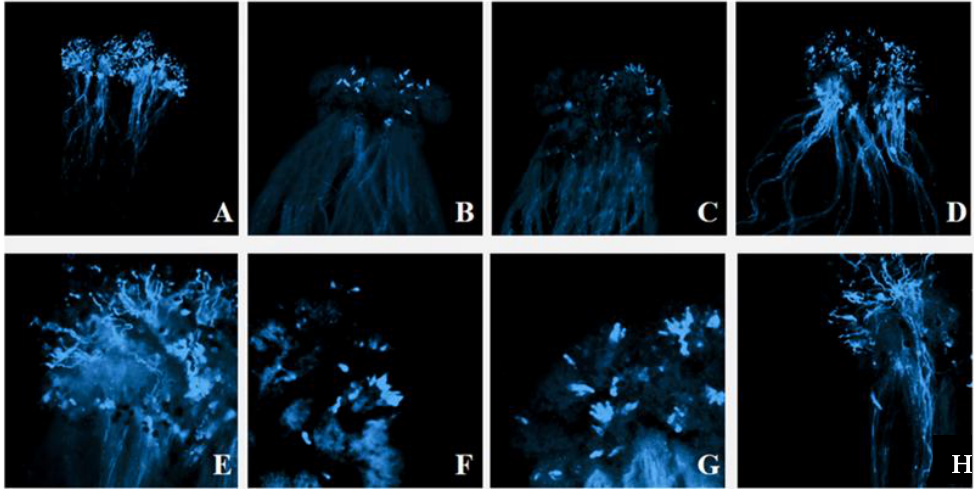
Figure 3. The germination of pollen tubes of different pollination combinations. ( A ). NAU-Rs4 (‘NAU- S25’) Bud pollination ⊗ (4 × ); ( B ). NAU-Rs4 (‘NAU-S25’) Flower pollination ⊗ (4 × ); ( C ). NAU-Rs4 × NAU-Rs40 (‘NAU-S25’) (4 × ); ( D ). NAU-Rs4 × NAU-Rs32 (‘NAU-S25’ × ‘NAU-S14’) (4 × ); ( E ).